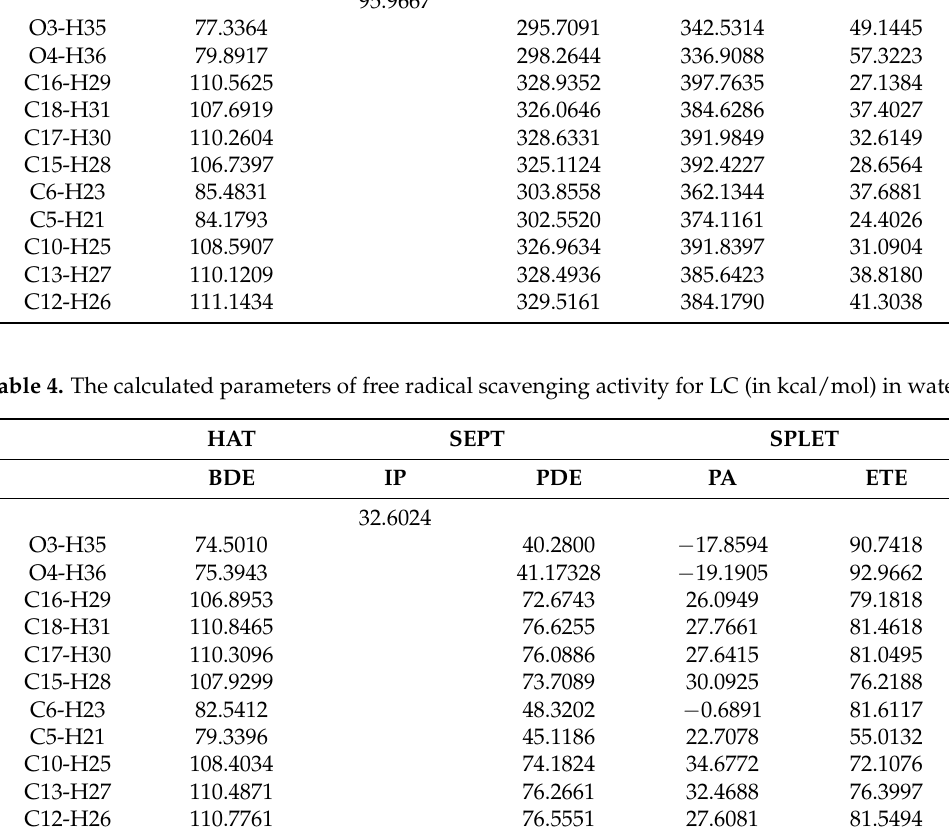
Table 5. Solvation enthalpies in water of H • , H + , and e − in kJ/mol.